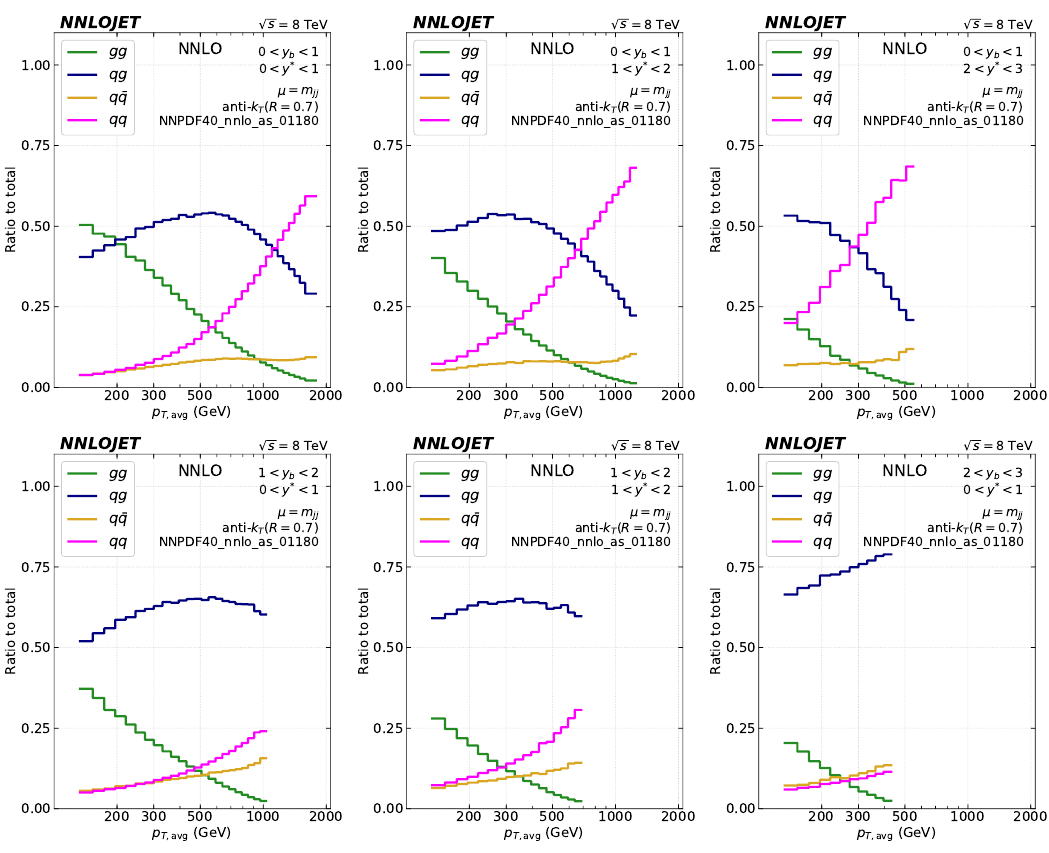
Figure 15 . Relative contribution of each parton-parton initial state to the total dijet cross section distributions in the different bins in ( y b , y ∗ ) , determined at